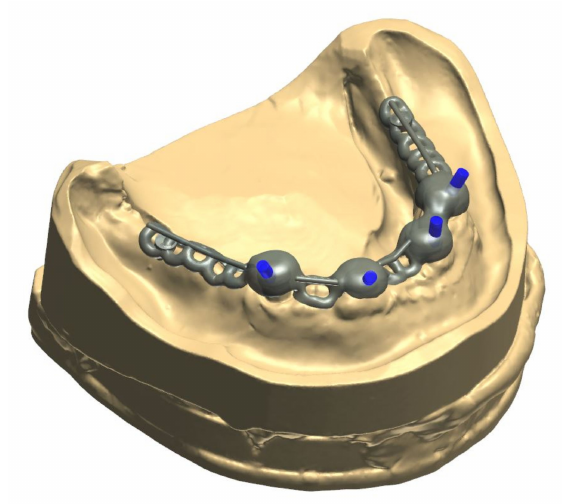
Figure 8. Digitally constructed alloy framework on the digital model of the lower jaw.